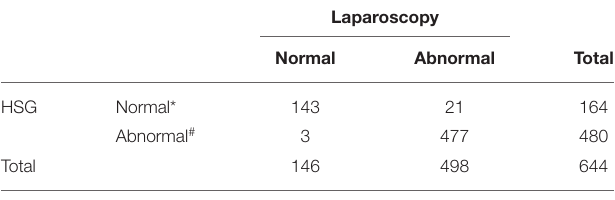
TABLE 4 | Diagnostic values of both tubes by HSG vs. laparoscopy.